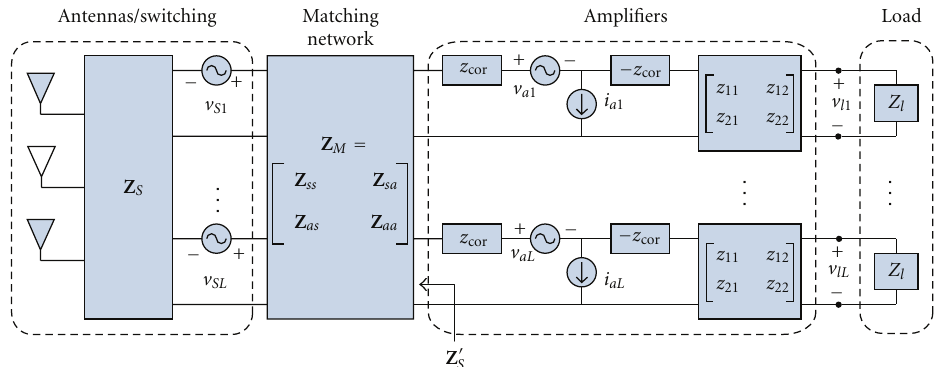
Figure 2: A circuit model of a receiver with antenna selection and mutual